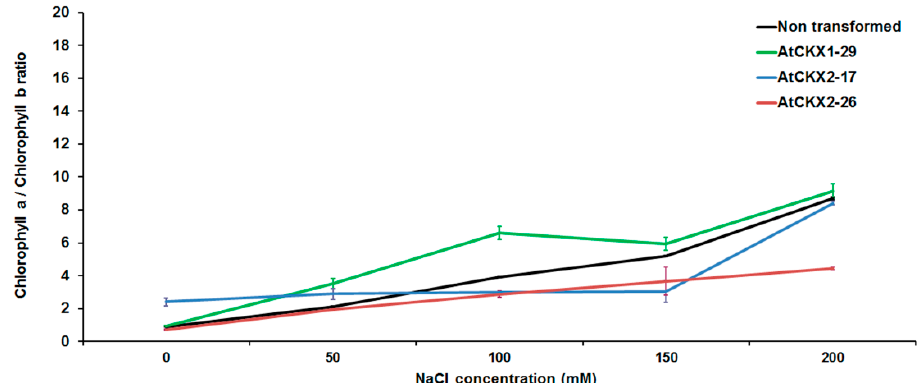
Figure 4. Chl a and Chll b ratio in the shoots of non-transformed and transgenic centaury lines ( AtCKX1 -29, AtCKX2 -17, and AtCKX2 -26) after 8 weeks of growth in ½MS medium supplemented with 0-, 50-, 100-, 150-, and 200-mM NaCl. The data represent the mean ± standard error. Means marked with a different letter significantly different from the control, according to the LSD test ( p ≤ 0.05), are presented in Supplementary Materials.